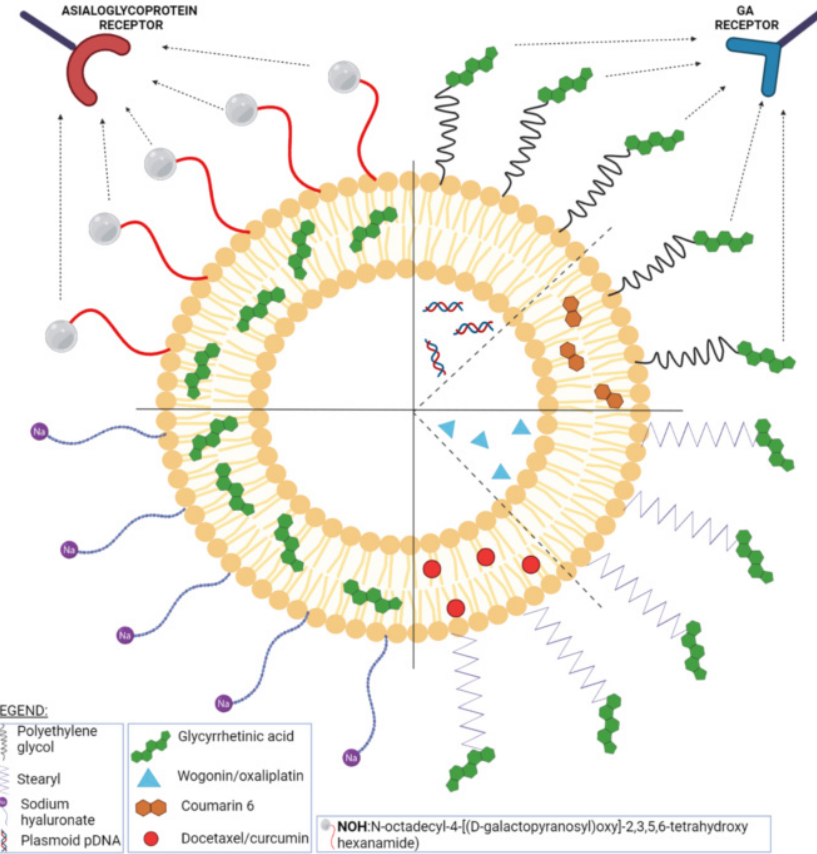
Figure 21. Schematic representation of different reported GA liposomal formulations. Created with BioRender.com (accessed 10 January